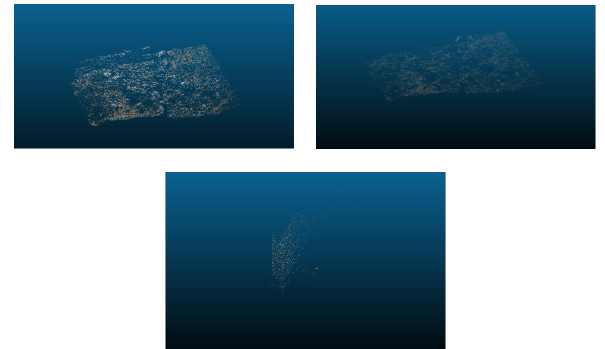
Figure 6. Semantically enriched 3D point clouds created using the Triangulation algorithm. First row presents the point clouds created exploiting the aerial images while the second row exploiting the terrestrial images